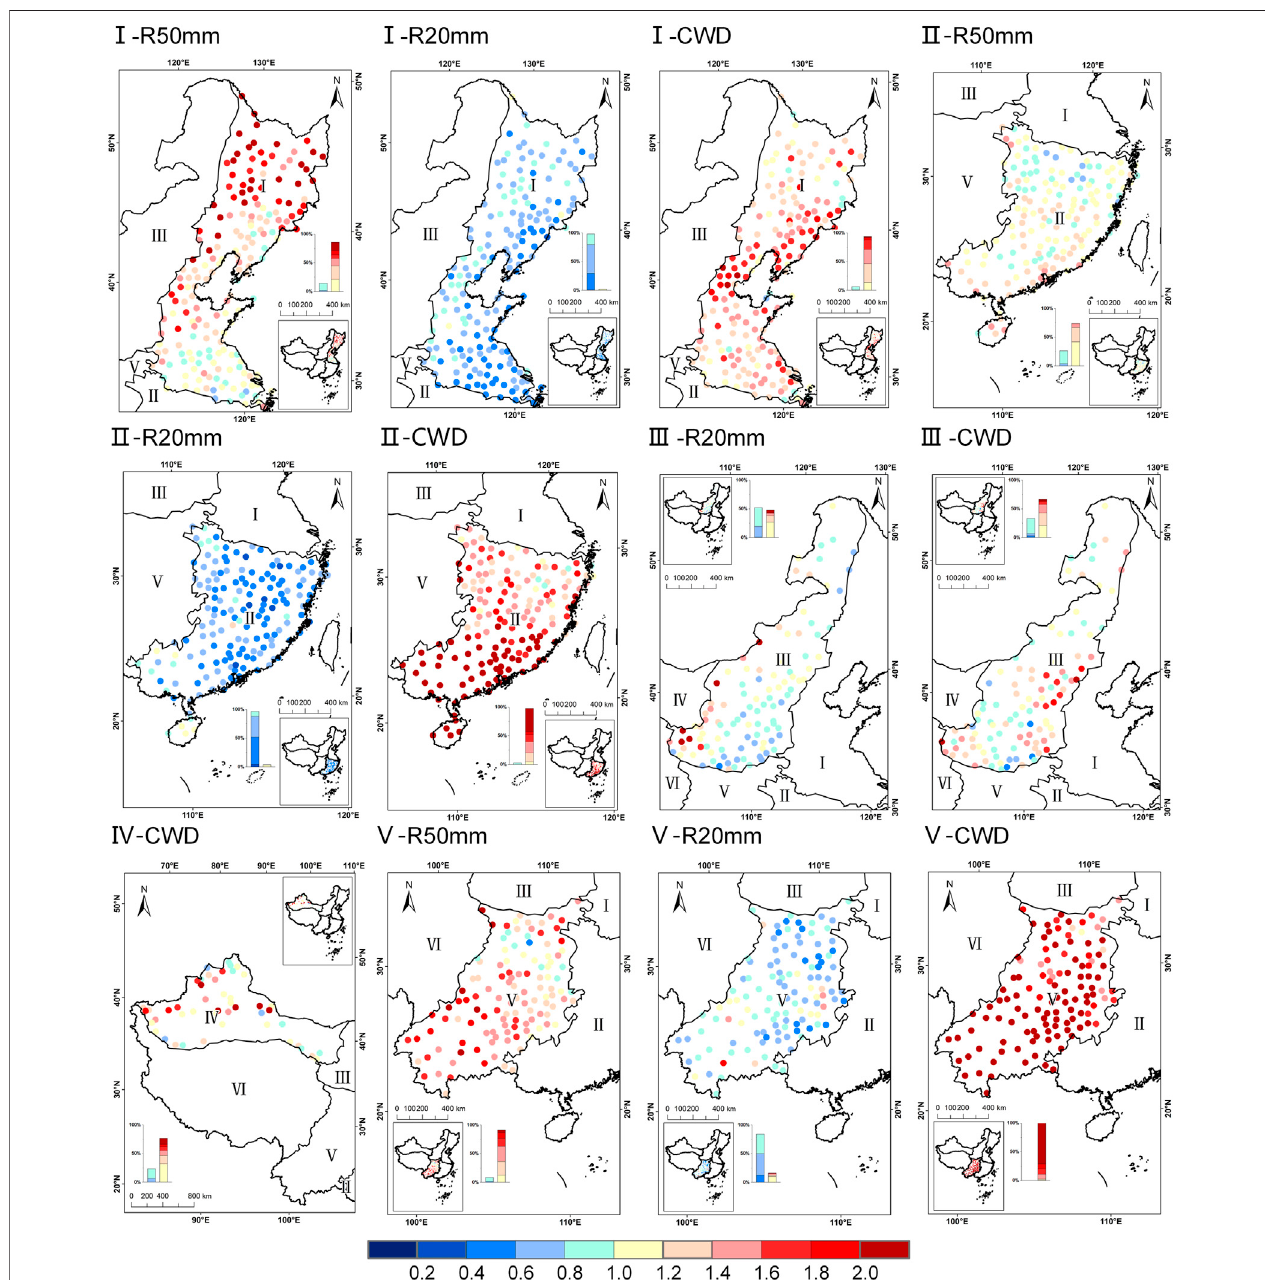
FIGURE 5 | Spatial distribution of DISO for the regional extreme precipitation indices of ERA5 in six regions.